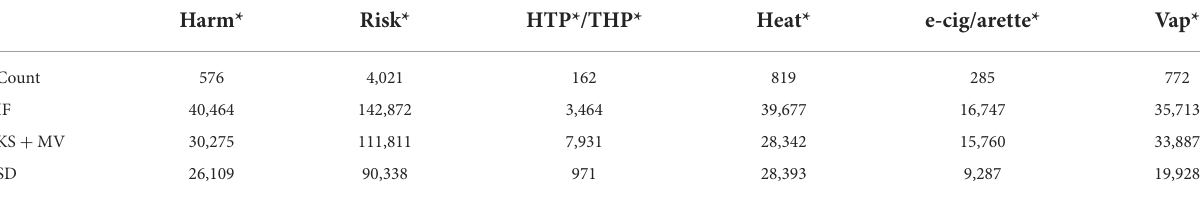
TABLE 5 Content coded by each coder across keywords.